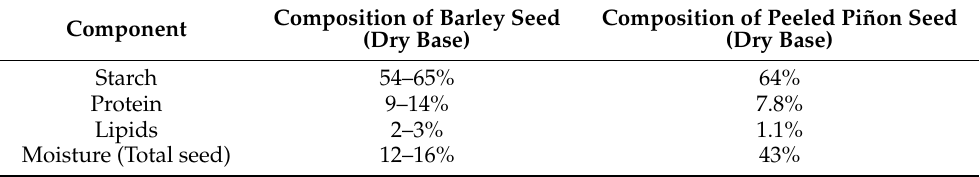
Table 1. Comparison between barley and piñon seed [15,16].